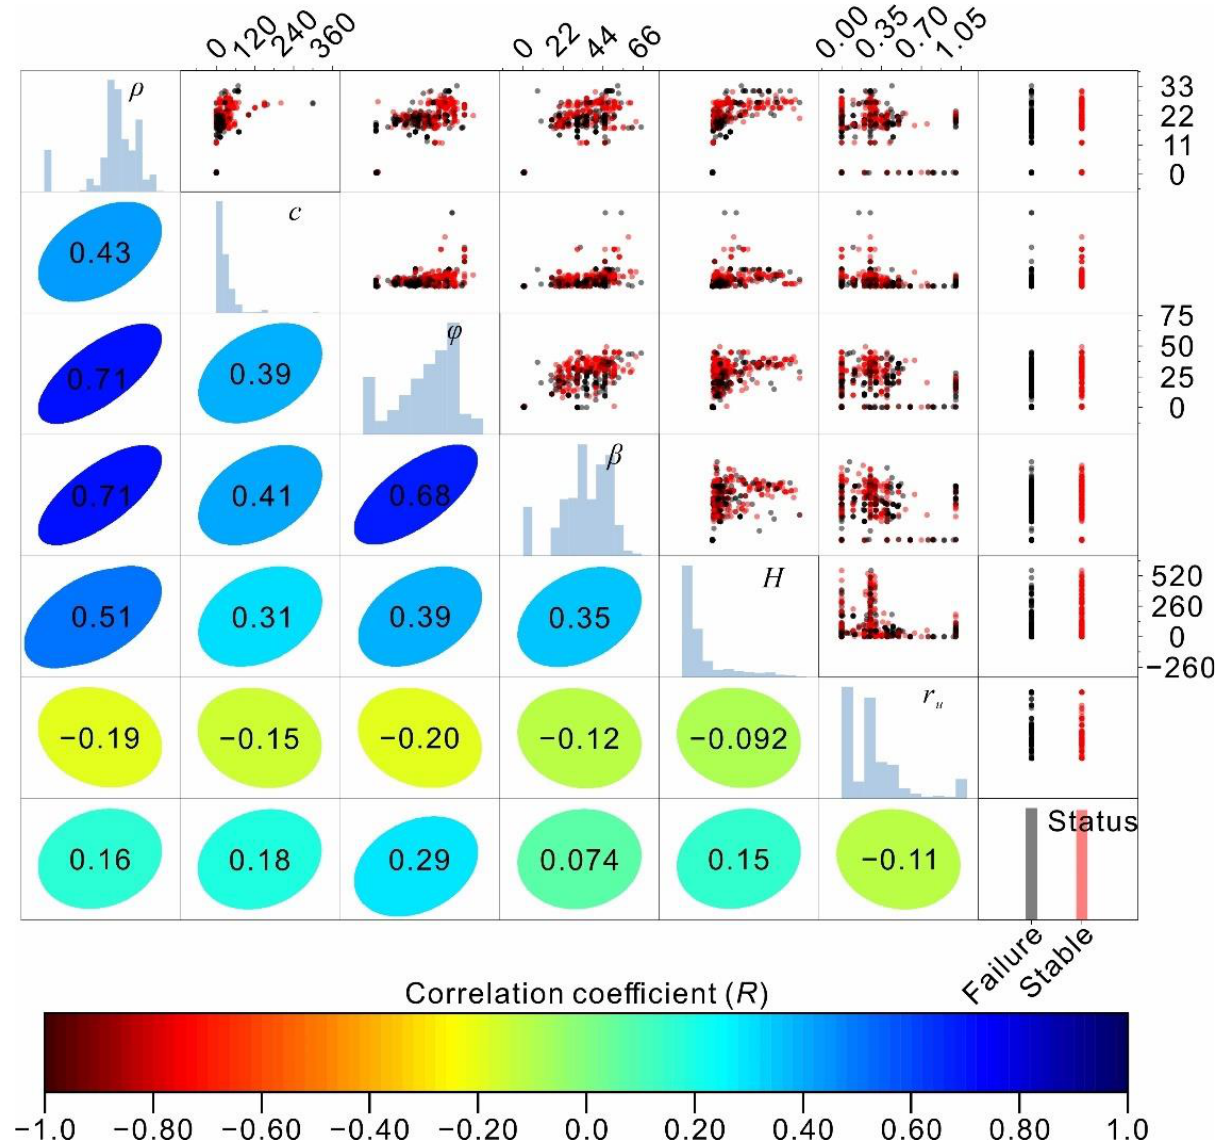
Figure 2. Scatter matrix showing the collected dataset. The panels in the upper right show the data points, and the lower left half of the figure shows the correlation coefficients between the features and the slope stability status.